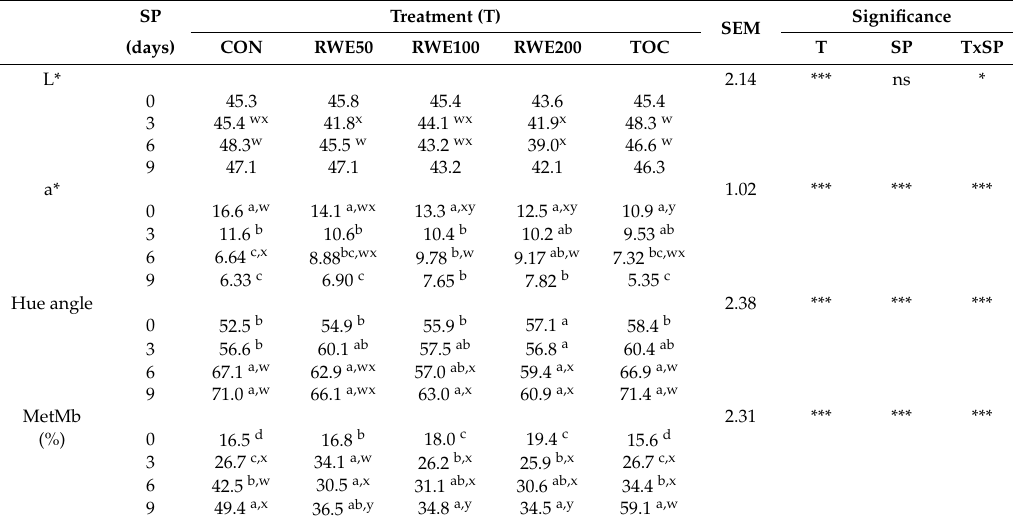
Table 1. Instrumental colour parameters measured in n -3-enriched lamb meat patties over the 9-day storage period (SP) in high oxygen modified atmosphere packs (HiOx-MAP), containing different levels of antioxidants. SP